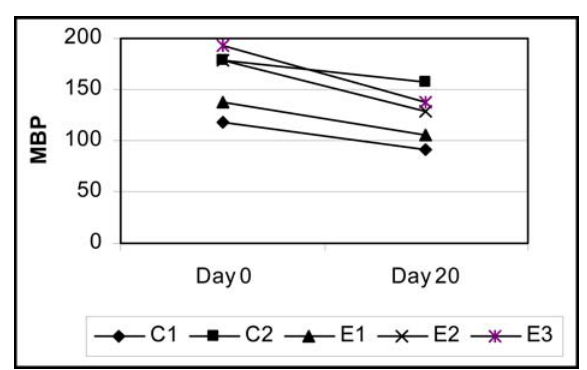
FIGURE 3 - Rats mean blood pressure (MBP) profile during pregnancy. DBP values decreased significantly in Day 20 compared with Day 0 in all groups (p<0.001), except C2.